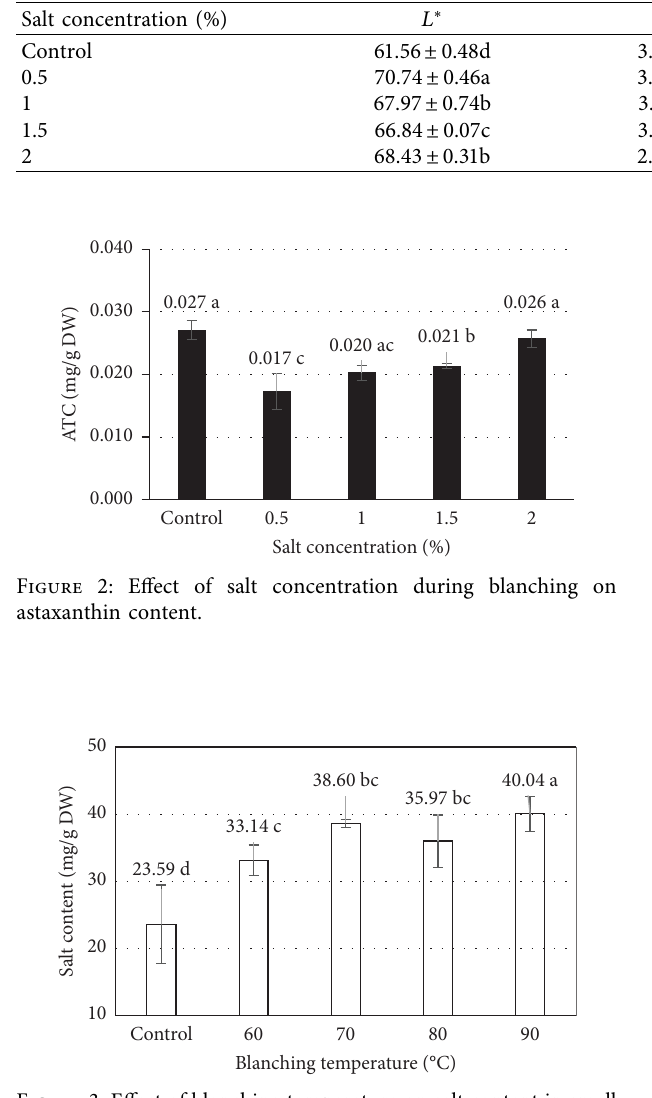
Figure 3: Efect of blanching temperature on salt content in small